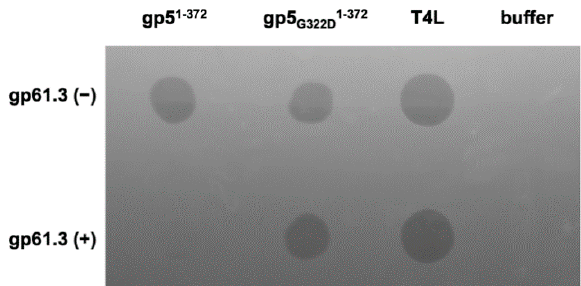
Figure 4. Lysozyme halo formation assay with chloroform vapor-treated E. coli lawn. Purified gp5 1-372 , gp5 G322D1-372 and T4L were spotted with (bottom row) or without (top row) gp61.3 (see M&M for detail).